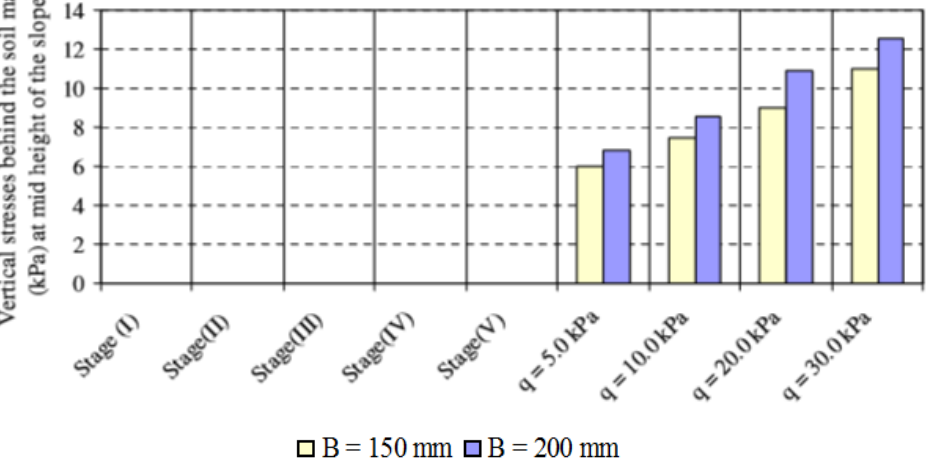
Figure 25. Influence of footing width on Vertical stresses behind the nailed soil mass at mid-height of slope.